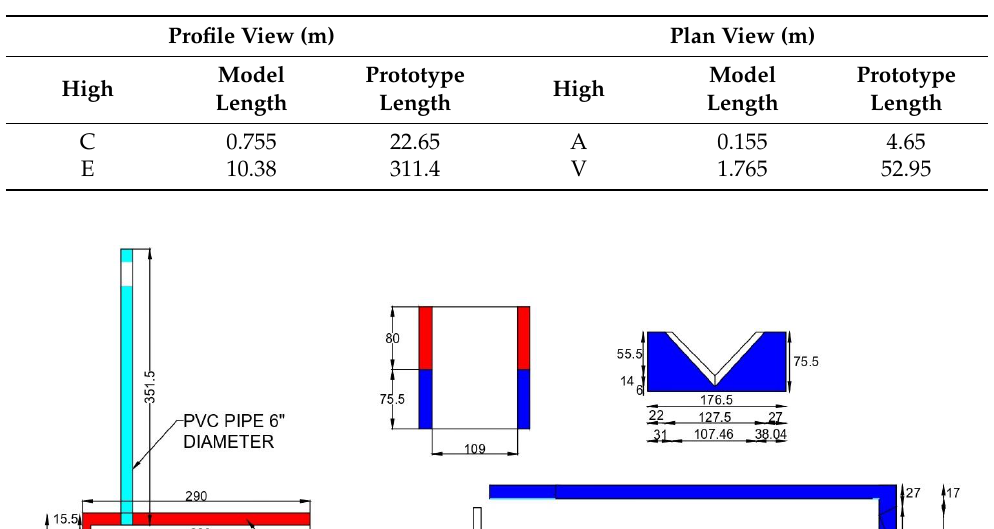
Table A1. Forensic hydraulics channel and an instantaneous opening gate dimensions.